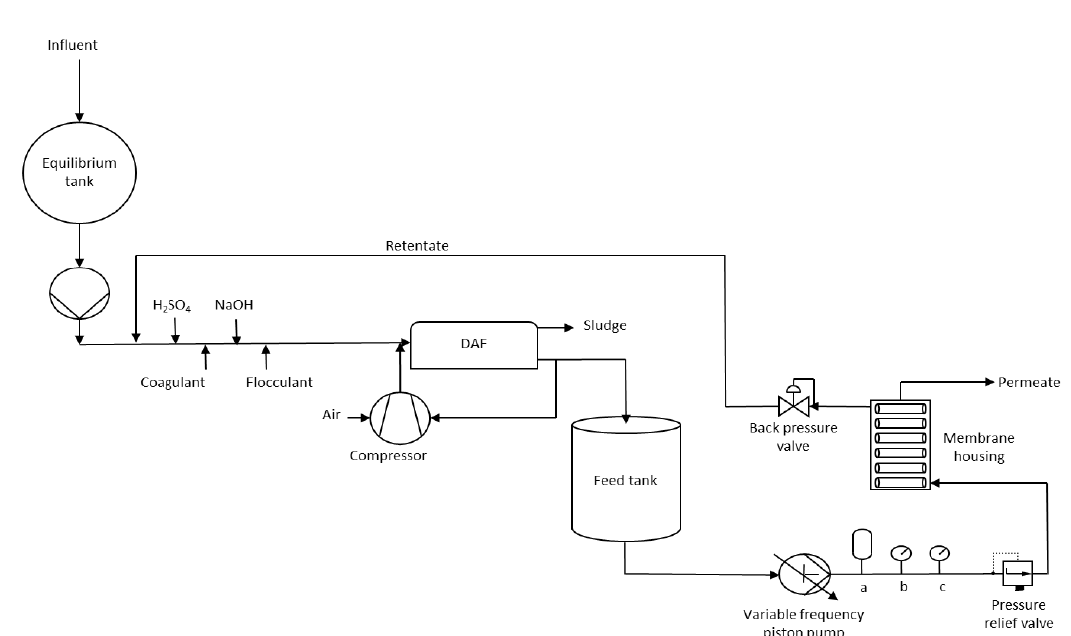
Figure 4. Process flow for post-DAF membrane filtration experiment. a—Baffler; b—Temperature sensor; c—Pressure sensor.